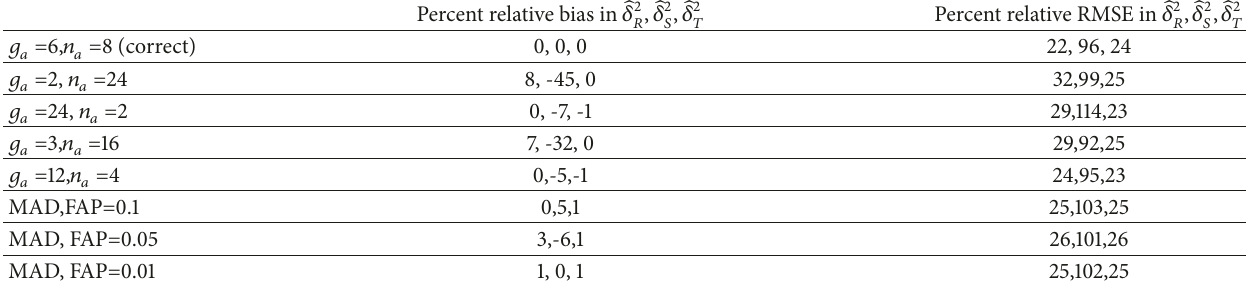
Table 1: Performance of estimators of negative estimates of RMSEs for 𝑔 =12, 𝑛 = 4 agree with that predicted by (7) for splitting each group into 2 groups.